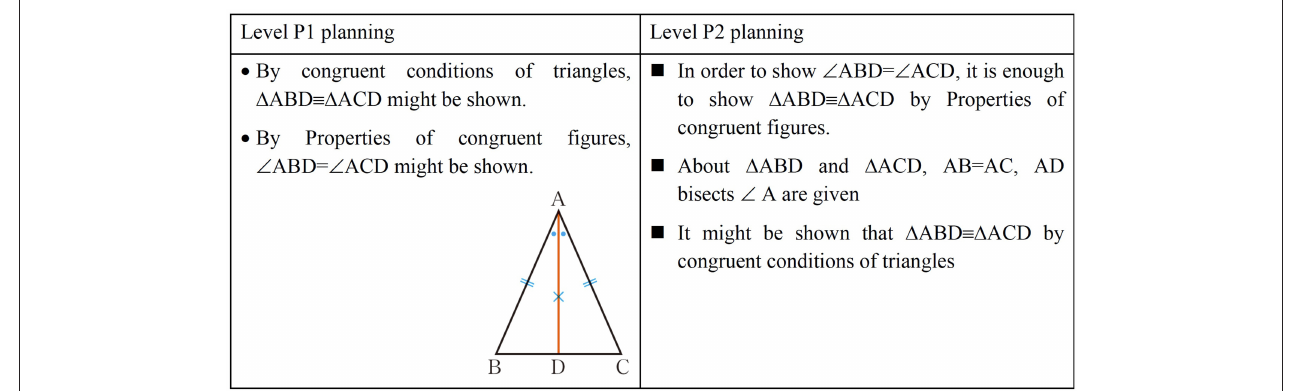
FIGURE 2 | Examples of the learning levels of planning a